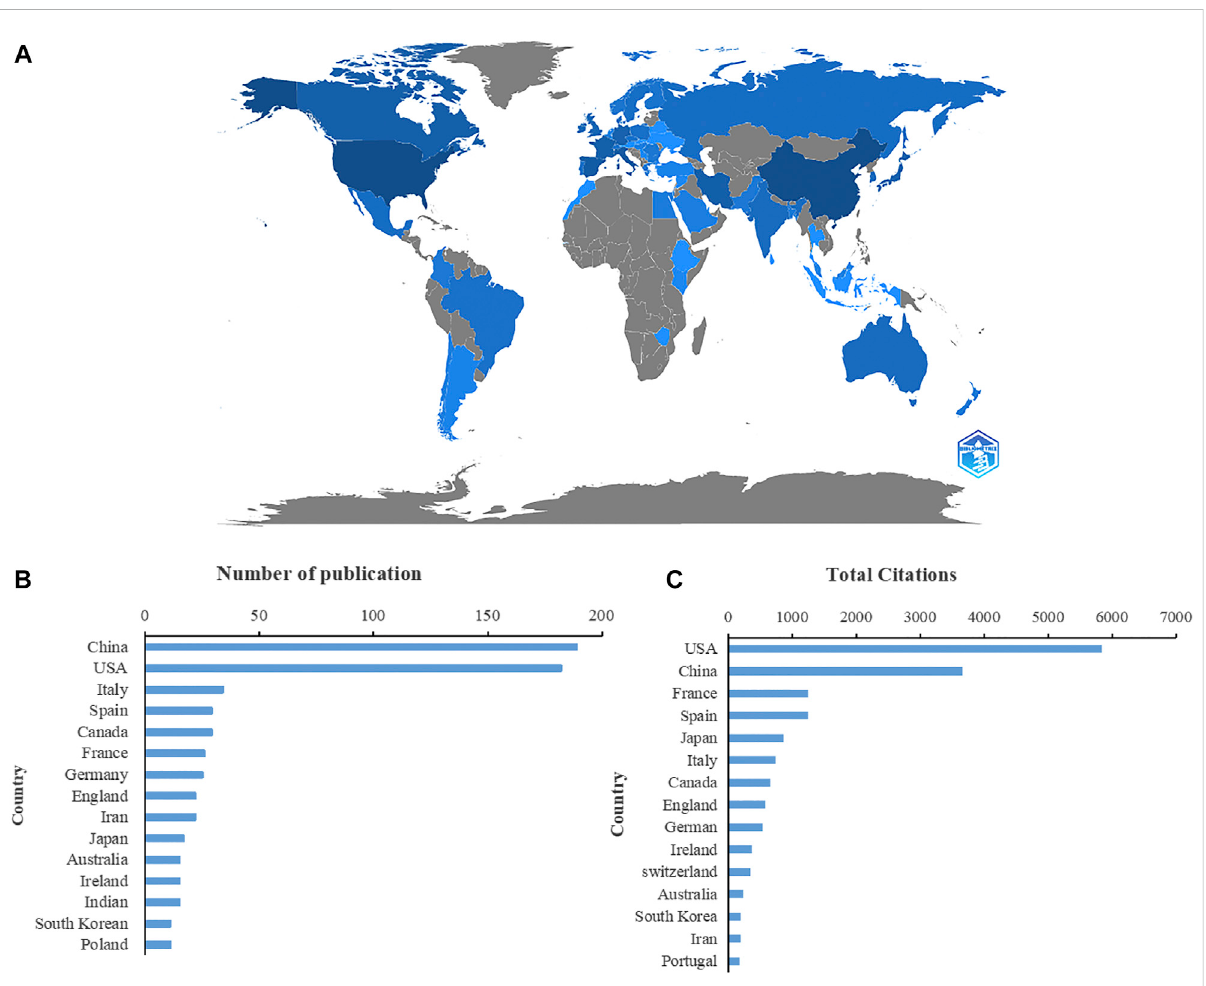
FIGURE 2 Countries contributing to the study of miRNA-microbiome interaction. (A) Distribution of countries in this area on a global map. The darker the blue, the more the number of documents produced by the country. (B) The number of publications of the top 15 countries. (C) Total number of citations of relevant papers from the 15 leading